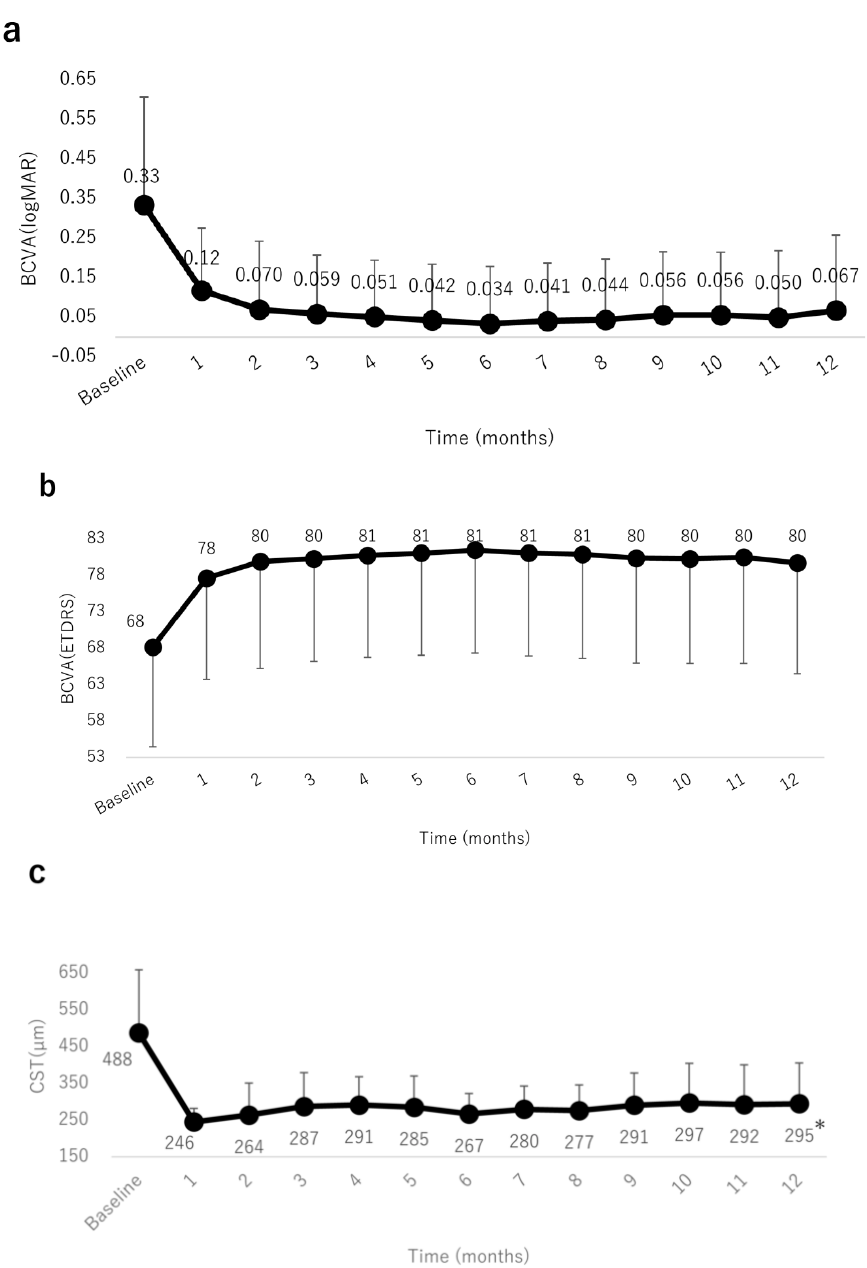
Figure 3. Mean BCVA (logMAR) and mean change from baseline BCVA (Early Treatment Diabetic Retinopathy Study (ETDRS) letter score) over time to month 12. ( a ) The mean BCVA improved significantly at month 1 after intravitreal aflibercept (IVA) injection, and the improvement continued through month 12. ( b ) The mean change from the baseline BCVA significantly increased over time through month 12. ( c ) The mean central subfield thickness (CST) over time to month 12. The mean CST improved significantly at month 1 after IVA injection, and the improvement was sustained through to month 12. *: p < 0.0001.